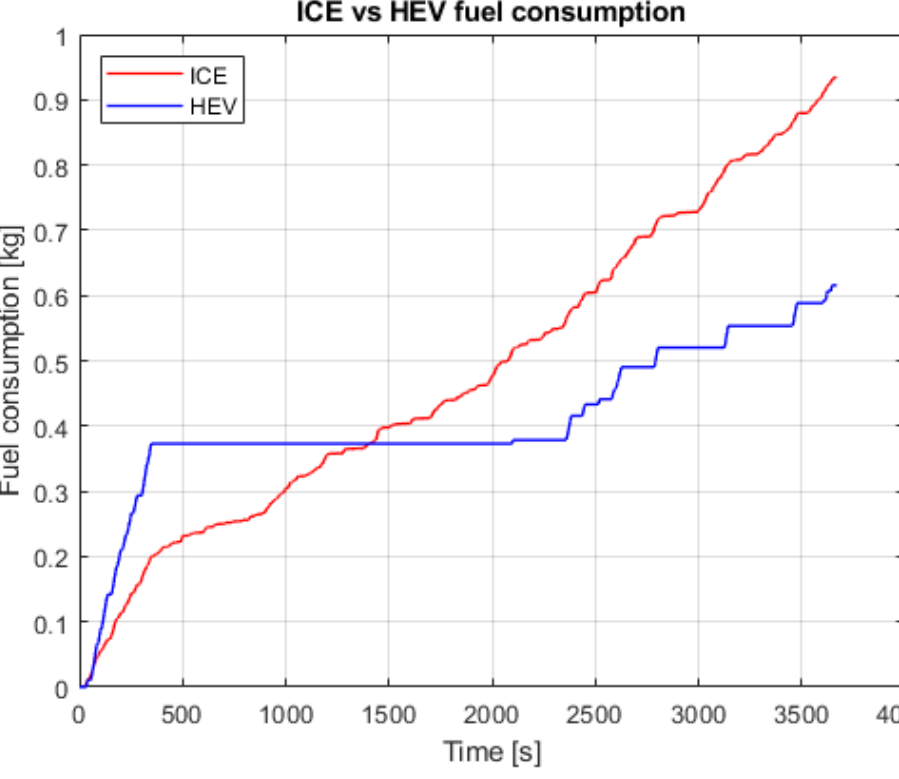
Figure 13. Fuel consumption evaluation for ICE vehicle model and HEV vehicle model.